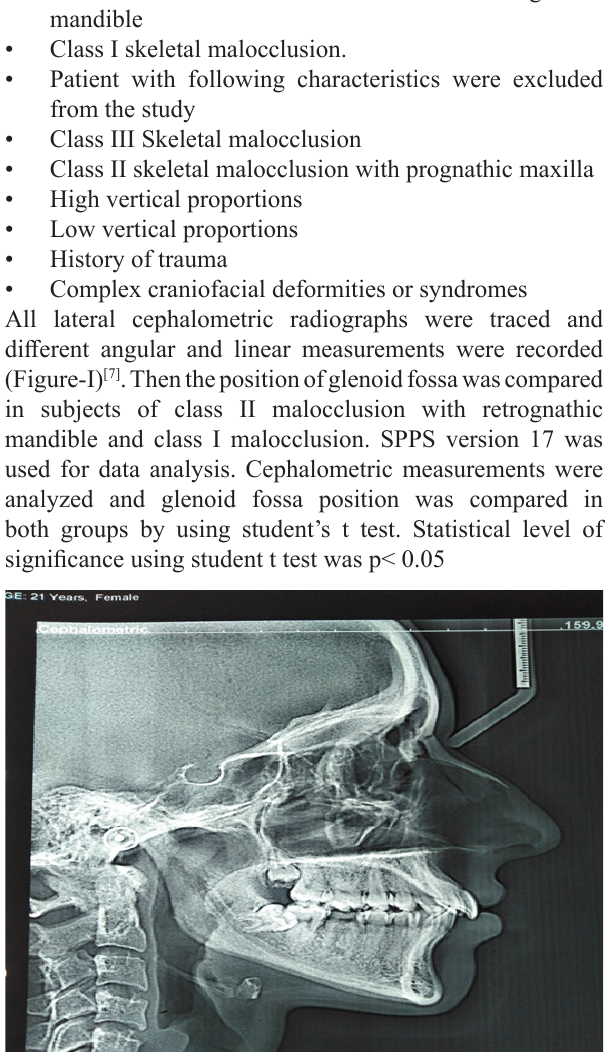
skeletal groups Table-II. Descriptive statistics of GF-S on FH, GF-Ptm on FH and GF-FMN were calculated in less